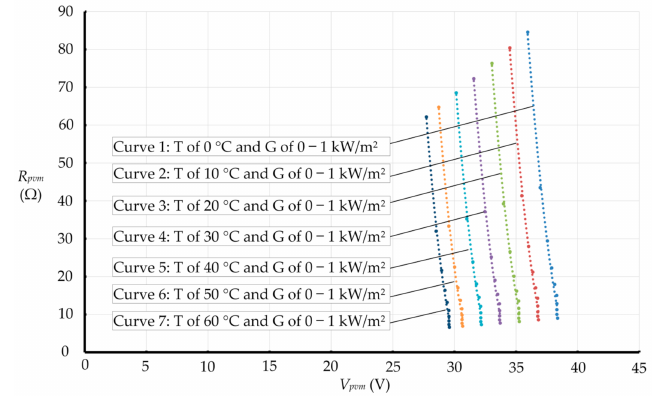
Figure 2. Relationship between V pvm , R pvm , T, and